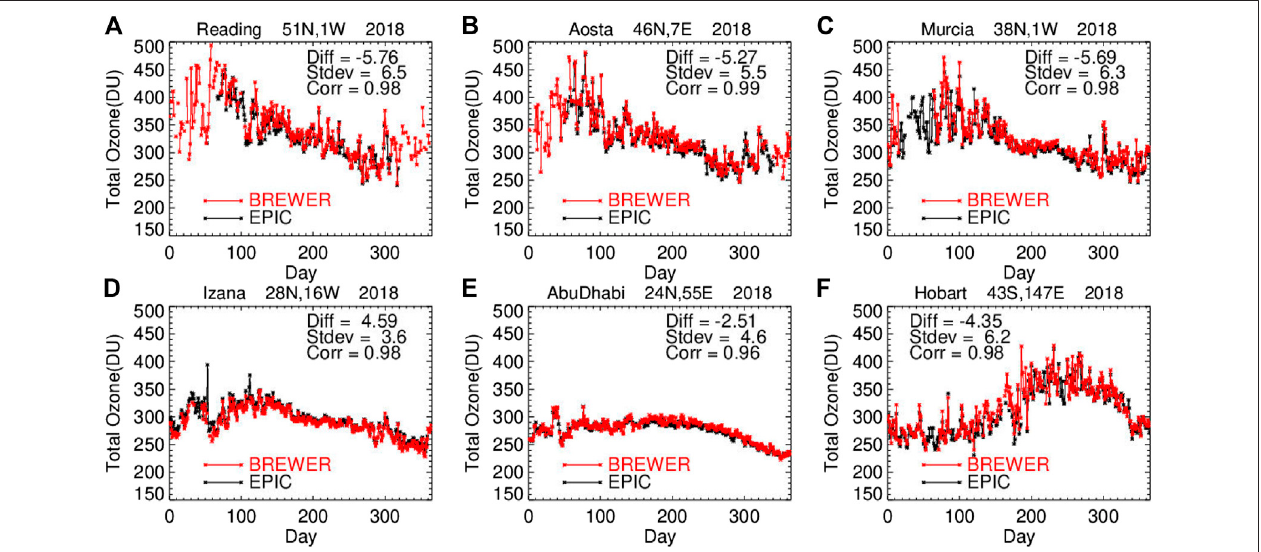
FIGURE8| Timeseriesofdaily-averageBrewerTOZmeasurements(red)andEPICv3dailyoverpasses(black)at6ground-basedstationsworld-widein2018: (A) Reading, United Kingdom, (B) Aosta, Italy, (C) Murcia, Spain, (D) Izana, Spain, (E) Abu Dhabi, United Arab Emirates, and (F) Hobard, Australia. The mean differences, standard errors of the mean in DU and correlation coef fi cients are shown at each panel.